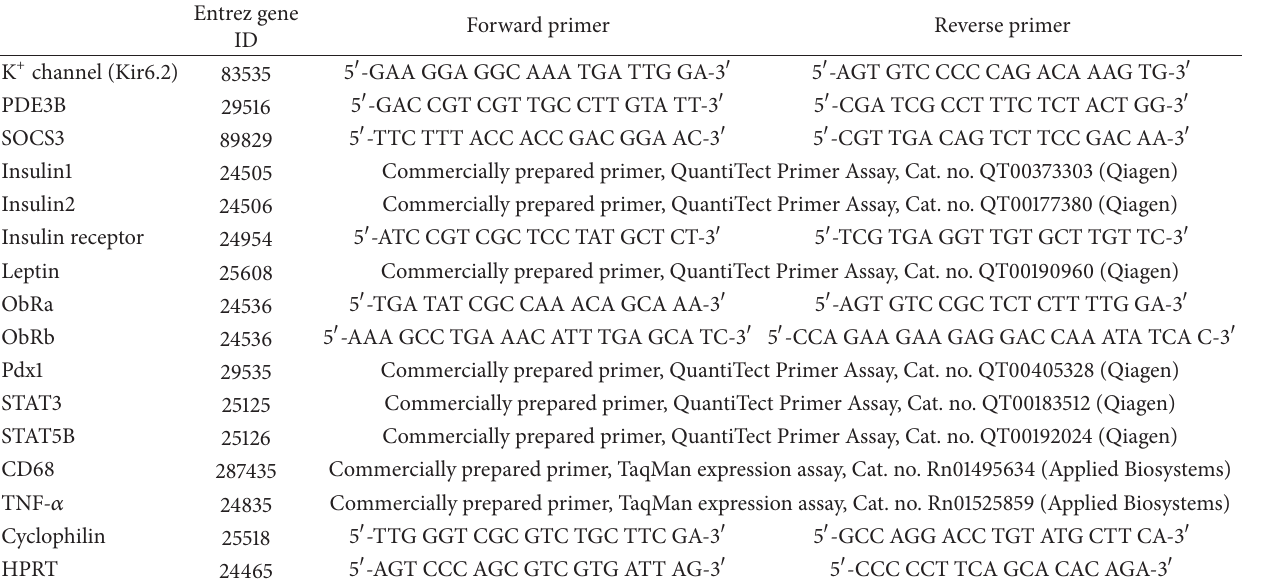
Table 1: Sequences of forward and reverse